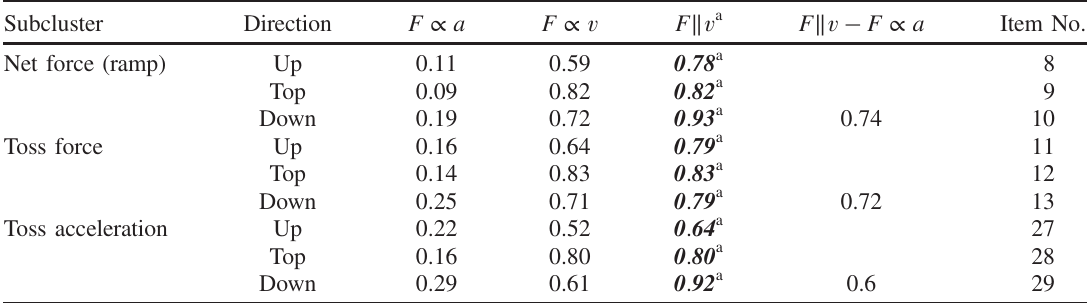
TABLE VI. Response rates for reversing direction force and acceleration.